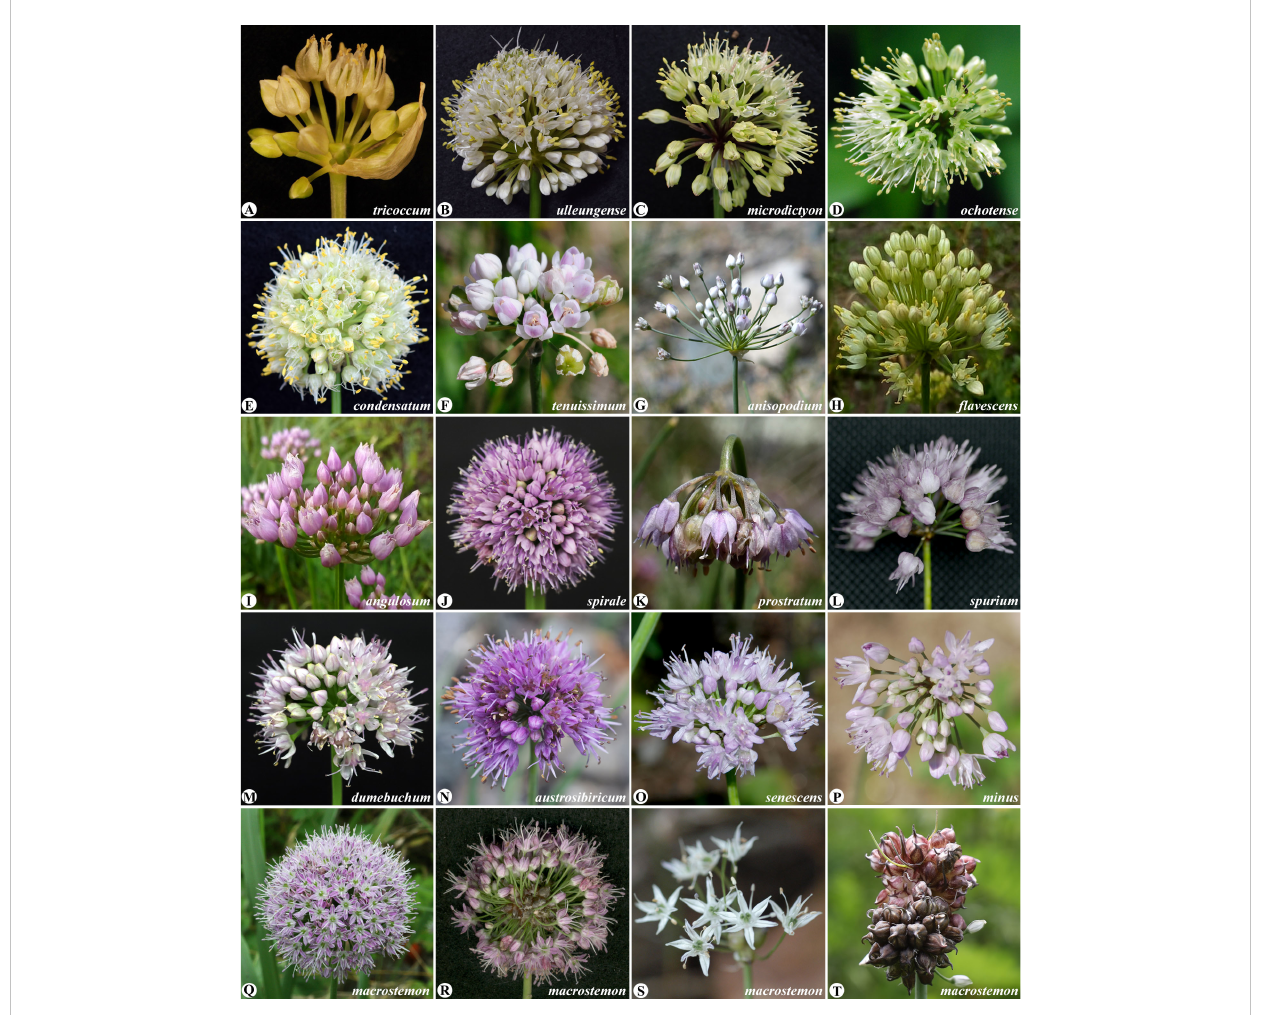
FIGURE 1 Species of Allium , especially from the two subgenera Anguinum and Rhizirideum , newly sequenced for their plastomes in this study. Subg. Anguimum : A tricoccum (A) , A ulleungense (B) , A microdictyon (C) , and A ochotense (D) . Subg. Cepa : A condensatum (E) . Subg. Rhizirideum : A tenuissimum (F) , A anisopodium (G) , A fl avescens (H) , A angulosum (I) , A spirale (J) , A prostratum (K) , A spurium (L) , A dumebuchum (M) , A austrosibiricum (N) , A senescens (O) , and A minus (P) . Subg. Allium : A macrostemon (Q-T) show fl oral variations. Photo credit: Hyeok-Jae